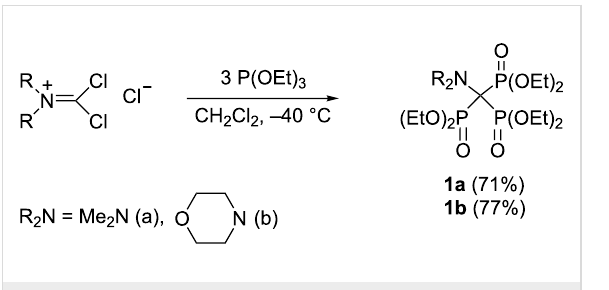
Scheme 1: Synthesis of hexaethyl dialkylaminomethylidynetrisphos- phonates 1 from dichloromethylene dialkylammonium